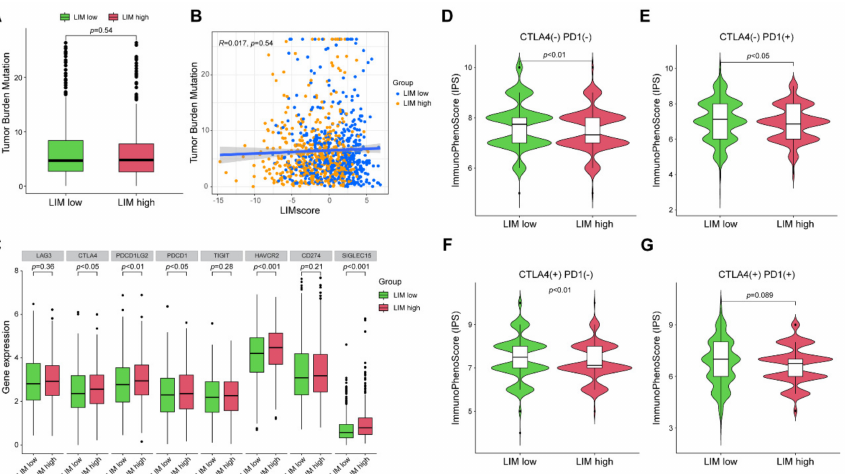
Figure 5. Relationship of LIM signature with tumor somatic mutation and immunotherapy. ( A ) The tumor mutation burden (TMB) of the LIM-low and the LIM-high groups. ( B ) Correlations between LIMscore and TMB. ( C ) The expression levels of immune checkpoints in the LIM-low and the LIM- high groups. ( D – G ) The immunotherapy response between the LIM-low and the LIM-high